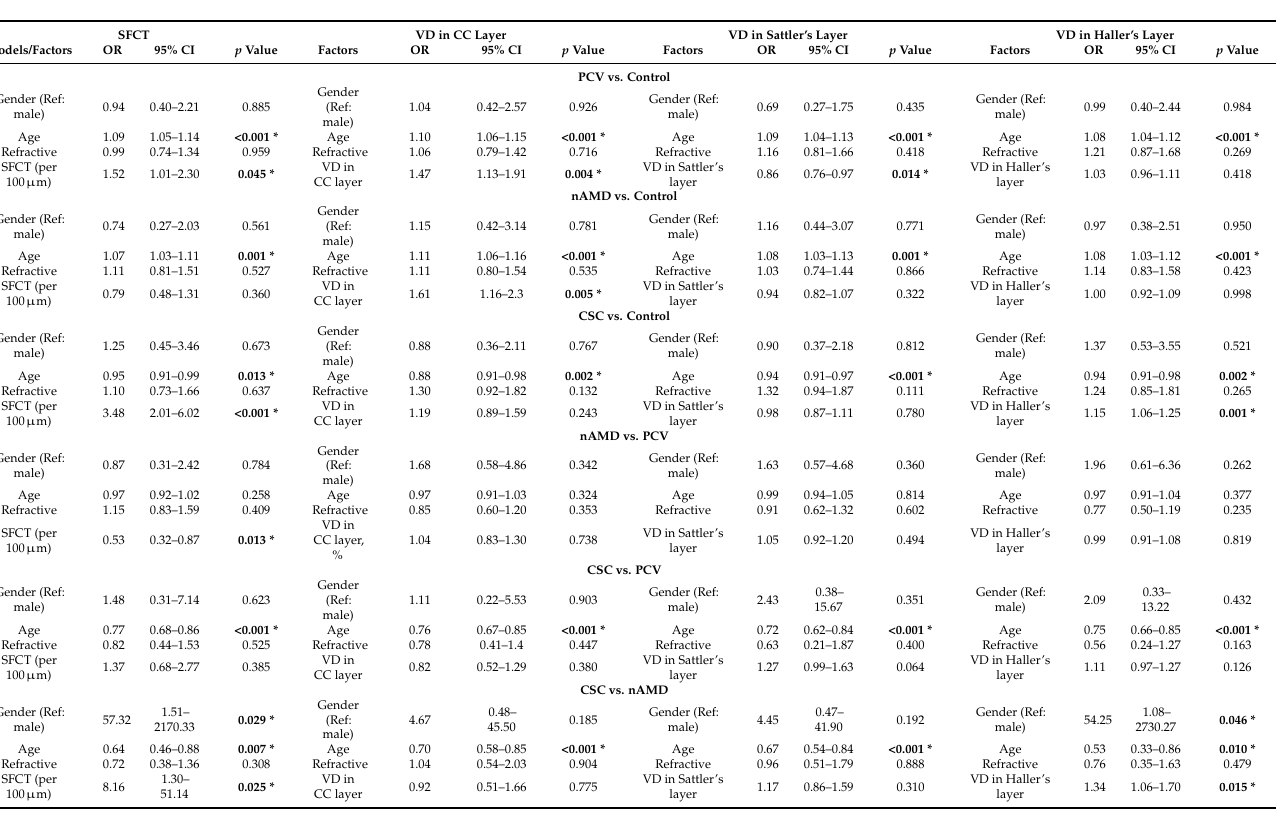
Table 3. Multivariate logistic regression models showing the statistical difference in SFCT and the vessel density in the CC, Sattler’s, and Haller’s layers between the PCV, nAMD, CSC, and normal control